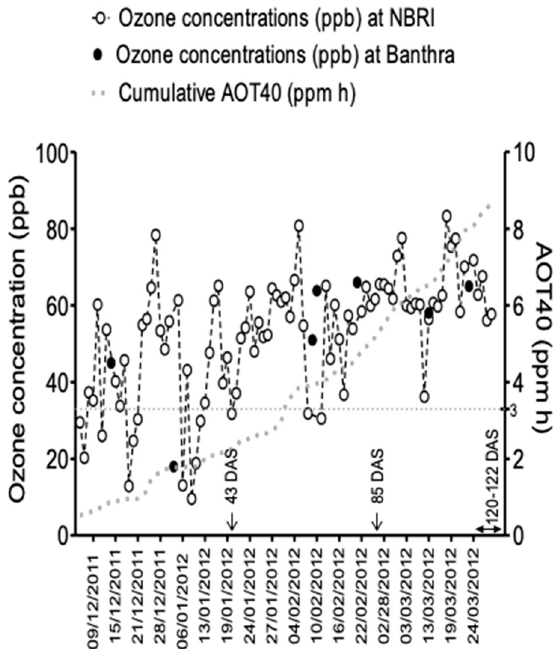
Figure 2. Variation in 8 h (9:00 to 17:00) average ozone concentration at NBRI (open circles) and Banthra (closed circles) sites. Accumulated Ozone exposure over the Threshold of 40 ppb (AOT40) accumulation during the experimental period (6 December 2011 to 29 March 2012) is indicated by grey dashed line. Horizontal line indicates the AOT40 threshold for wheat (3 ppm h). Arrows denote the sampling dates for analyses at vegetative phase (43 days of sowing (DAS)), flowering phase (85 DAS) and harvest phase (120-122 DAS).